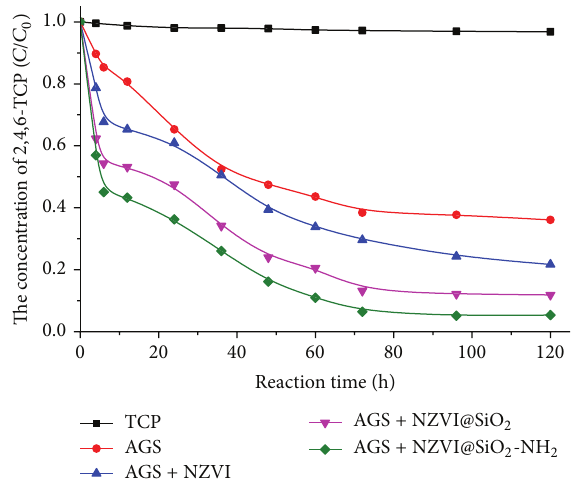
Figure 5: The degradation of 2,4,6-TCP in anaerobic granule sludge system adding different iron